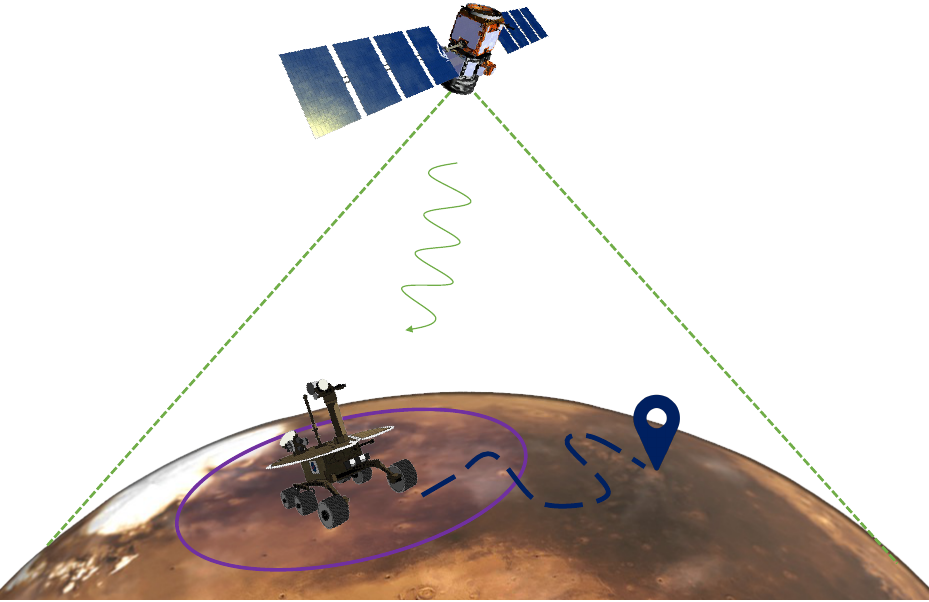
Figure 1. Sketch of the reference architecture. A rover with limited visibility receives a global path from a space-based